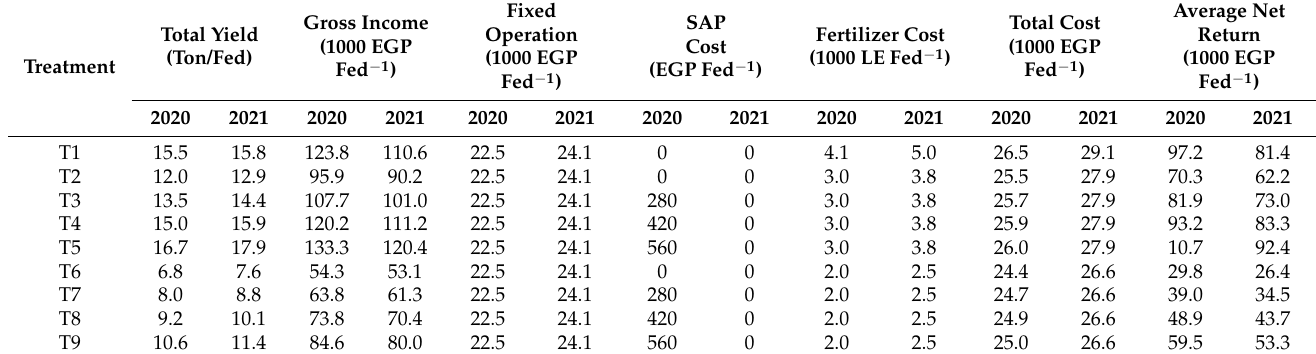
Table 10. Effect of mineral fertilizer alone or combined with superabsorbent polymers on net return of Autumn Royal grapevines in 2020 and 2021